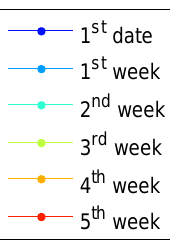
Figure 21. GPS almanac using period test for five